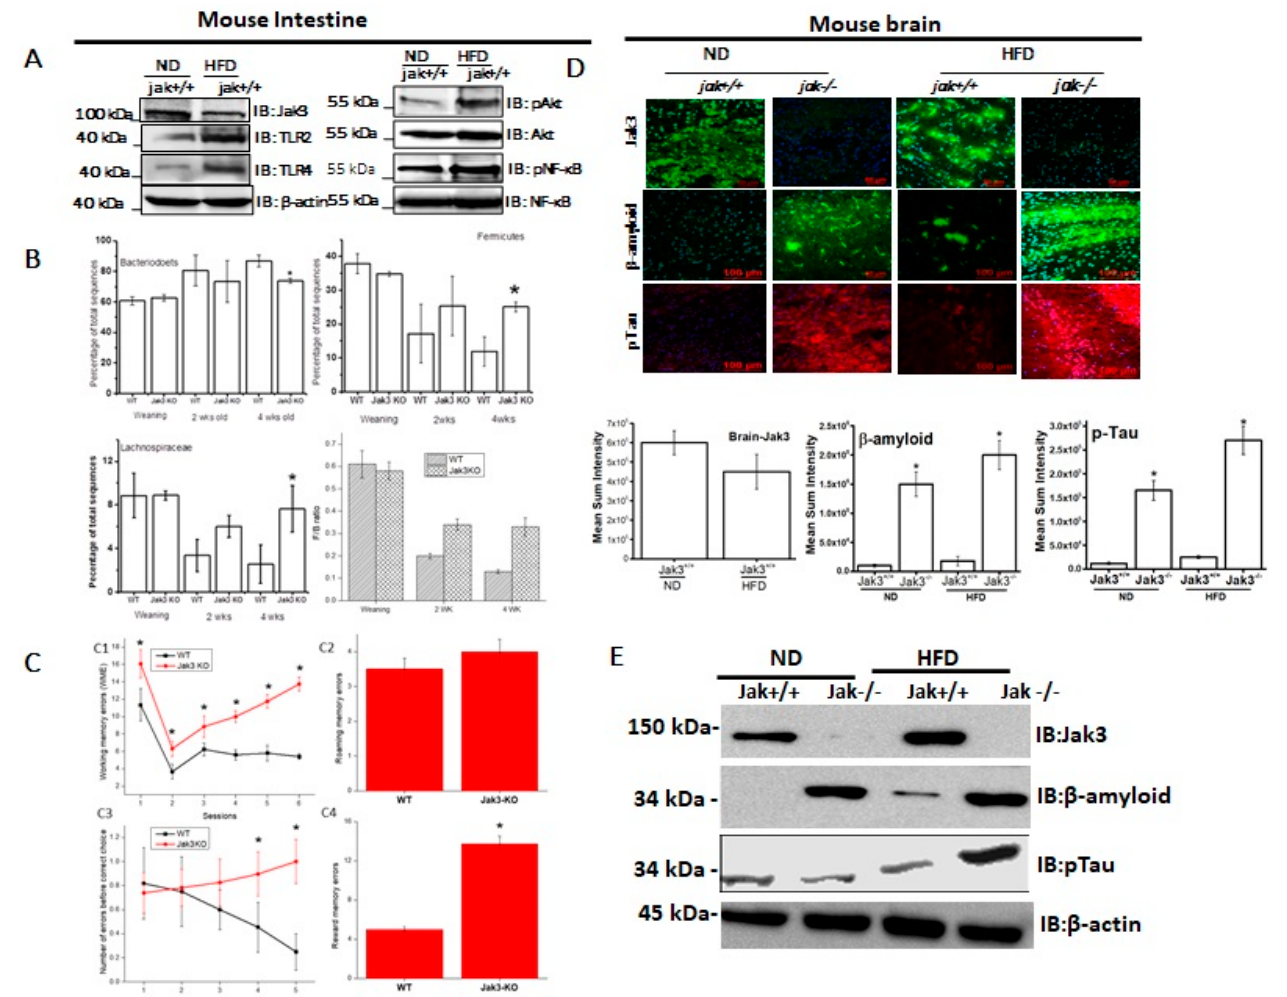
Figure 1. High-fat diet (HFD) reduces intestinal expression of Jak3, and Jak3 deficiency in mice leads to colonic dysbiosis, cognitive impairment and accumulation of β -Amyloid and pTau in obese mouse brain. ( A ) Colons from normal diet (ND) and HFD-fed mice were excised out, and Western blot analysis was performed using the tissue lysates for the indicated proteins using β -actin as controls. Representative blots ( n = 3) are shown. ( B ) Jak3 deficiency promotes gut dysbiosis. Gut microbiome composition was determined using a commercial facility through 16sRNA pyrosequencing of fecal DNA samples from co-housed WT and Jak3-KO littermates ( n = 10 each group). The time courses of changes in fecal microbiota from WT and Jak3-KO mice are shown through the shift in the relative abundance of specific taxa (Upper panels; UP), specific family (Lower left panel; LLP), and the time courses of the relative shift in Firmicutes to Bacteroidetes ratio (F/B) (Lower right panel; LRP) are shown. Statistical analysis was performed using repeated measures paired group analysis of variance. Error bars represent +/ − SEM. * indicate statistically significant differences compared to WT (ULP; p = 0.004, URP; p = 0.002, LLP; p = 0.001). ( C ) Jak3 deficiency promotes cognitive impairment. Automated elevated radial arm maze equipped with MazesoftTM Software was used to calculate the four parameters of cognitive assessments, viz., working memory errors (WME) (Upper left), roaming memory errors (RME) (Upper right), number of errors before a correct choice (EBCC) (Lower left) and reward memory errors (RWME) (Lower Right) over five sessions. A repeated-measure ANOVA on performances of age- and sex-matched wild-type (WT) littermate controls of Jak3-KO mice ( n = 20 each group) are shown for each session (Upper and lower left panels) or an average of all the sessions (Upper and lower right panels). All the data are representative of three independent experiments. Values are mean ± S.D. * denotes p < 0.05 compared with WT mice. (Upper left; p = 0.002, Lower left; p = 0.004, Lower right; p = 0.001). ( D ) Jak3 deficiency promotes accumulation of β -Amyloid and pTau in mouse brain. Brain tissue sections from WT and corresponding Jak3-KO littermate mice fed with either ND or HFD were immunostained using β -amyloid or pTau or Jak3